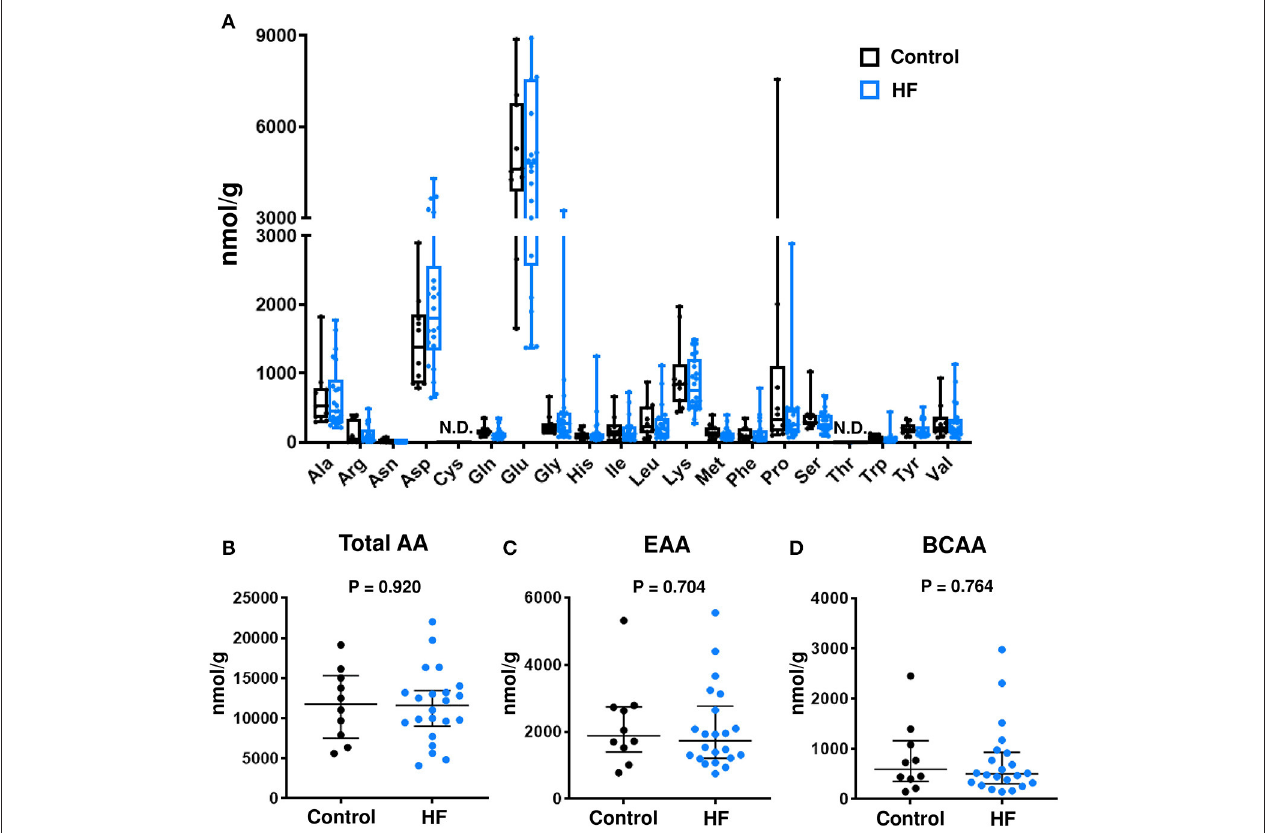
FIGURE 3 | Comparison of fecal amino acid (AA) concentrations between heart failure (HF) patients ( n each AA. In the box-and-whisker plot, the middle line represents the median value, the box indicates interquartile range (25–75th percentiles), and the range bars indicate the maximum and minimum values. (B) Fecal concentrations of total AAs. (C) Fecal concentrations of total essential AAs (EAAs), including His, Ile, Leu, Lys, Met, Phe, Thr, Trp, and Val. (D) Fecal concentrations of branched chain AAs (BCAAs), including Leu, Ile, and Val. (B–D) Data are presented as median range (25–75th percentiles). Ala, alanine; Arg, arginine; Asn, asparagine; Asp, aspartic acid; Cys, cysteine; Gln, glutamine; Glu, glutamic acid; Gly, glycine; His, histidine; Ile, isoleucine; Leu, leucine; Lys, lysine; Met, methionine; Phe, phenylalanine; Pro, proline; Ser, serine; Thr, threonine; Trp, tryptophan; Tyr, tyrosine; Val, valine; N.D., not